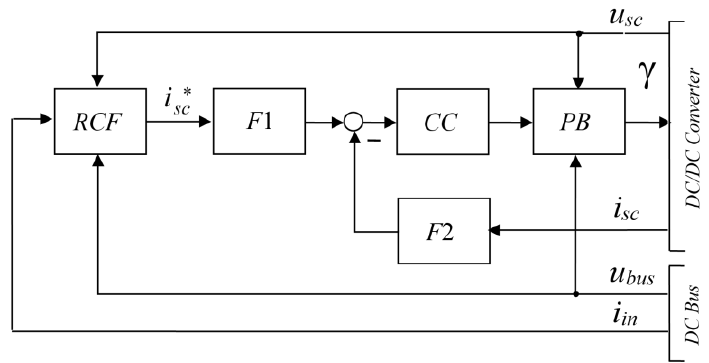
15 of 29 Figure 18. ZVT/ZCS converter topologies. 3.5. Discussion In low-voltage hybrid power sources for asynchronous controlled electric drives like supercapacitor energy storage devices, two topologies of DC / DC converters are widely used: a typical topology with a single-phase conversion method and topologies with a multiphase conversion method with a phase shift of 360°/ n . In high-voltage hybrid energy sources, a high-frequency transformer is a necessary element of galvanic isolation in supercapacitor energy storage circuits. This makes it eas- ier to match the levels of the input and output voltages when they differ greatly by in- stalling a transformer. The use of resonant inverters reduces the loss of active power at the intervals of turning on and off the switches. The main design criteria are the minimisation of dimensions and power losses and the reliability of supercapacitor energy storage devices. 4. Structures of Control Systems for Auxiliary Power Sources with Supercapacitors In regulated electric drives, auxiliary power sources are supplied with automatic con- trol systems (ACS), which address such key challenges [80 – 82] as maintaining the voltage at the input of a stand-alone voltage inverter with a given accuracy to eliminate voltage surge during braking and maintaining the charge/charge current within the specified lim- its of discharge and voltage at the supercapacitor module’s terminals. This review of ACS for auxiliary power sources will identify the general composition and principles of the regulation of variables, the types of regulators, and the criteria for setting control systems. As the analysis of the literature on this topic shows, single-circuit [11,18 – 20,23,27,36,41,64,71,72,83,84], double-circuit [16,22,34,53,70,73,85,86], and three-circuit [81,82,86] control systems are most commonly used. 4.1. Composition and Principles of Regulation of Variable Single-Circuit Automatic Control Systems When using a typical DC / DC converter topology (see Figure 2), the controlled varia- ble of single-circuit ACS is the current of the supercapacitor module ( i sc ). It is common to